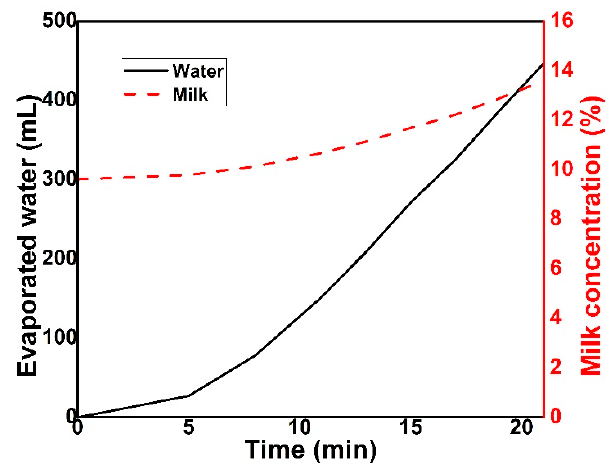
Figure 6. Relationship between the water evaporated and the concentration of milk during the process of Qishta production. Measurements were made in triplicate.